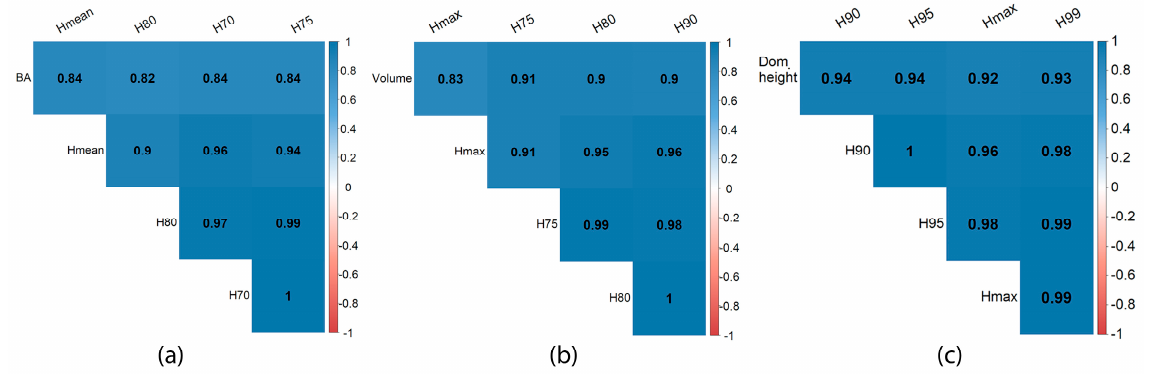
Figure 3. Pearson’s correlation coefficients for each response variable and the four highly correlated predictor variables. ( a ) Pearson’s correlation coefficients plot for BA; ( b ) Pearson’s correlation coefficients plot for volume; ( c ) Pearson’s correlation coefficients plot for dominant height.